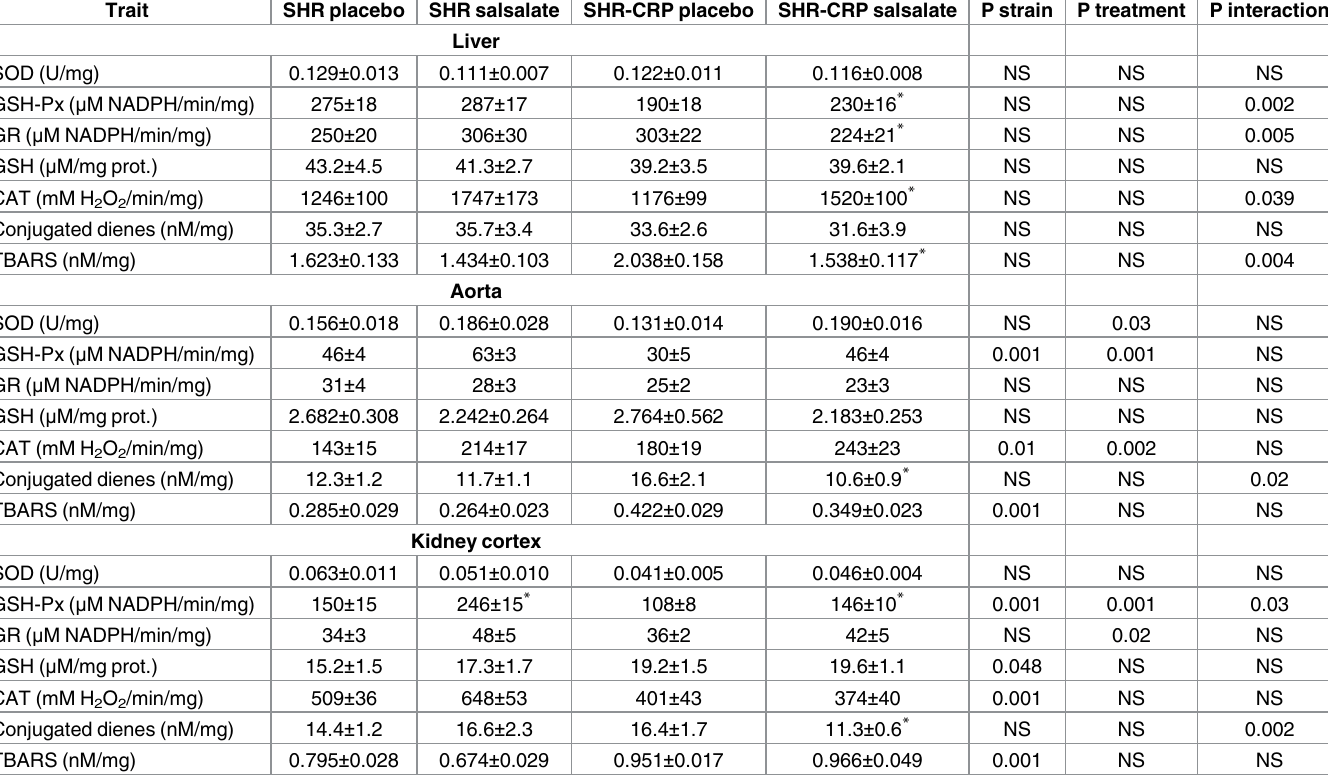
Table 1. Parameters of oxidative stress in the liver, aorta and kidney cortex in SHR-CRP transgenic and wild-type controls treated with salsalate or placebo.